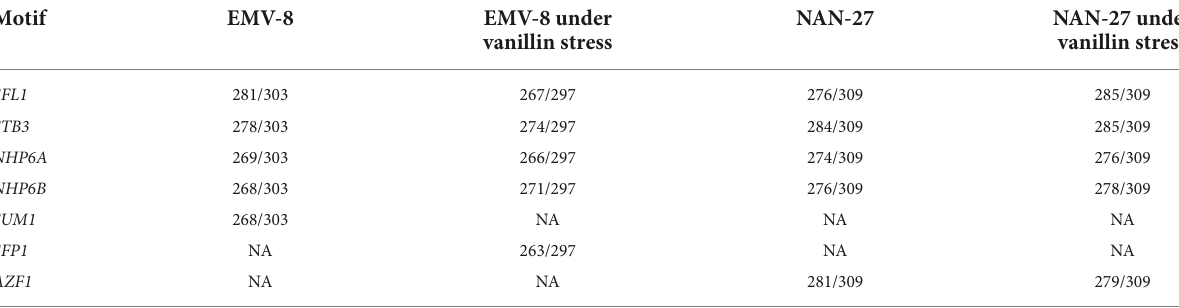
TABLE 3 The top five motifs enriched at TAD boundaries in EMV-8 and NAN-27 with or without vanillin.